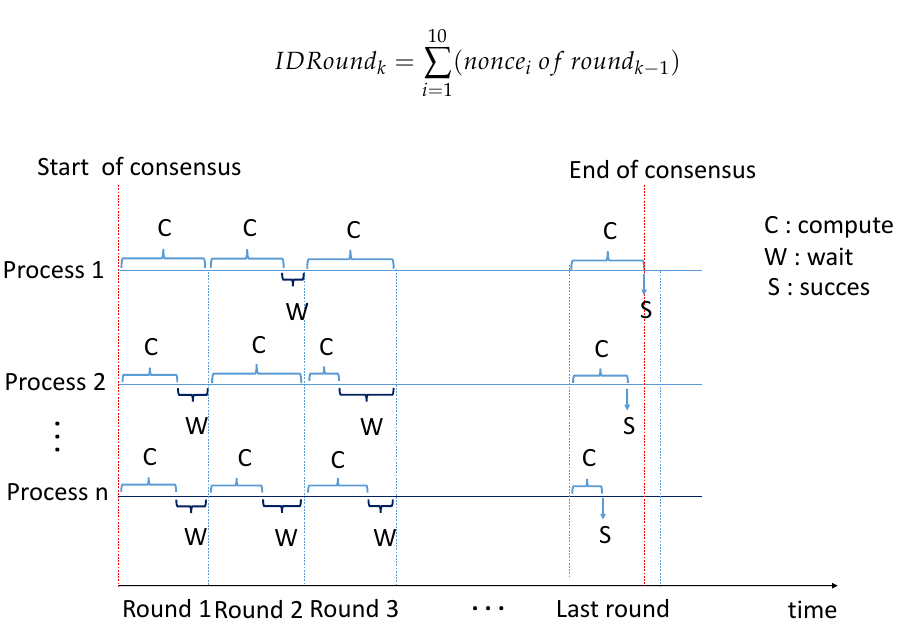
Figure 1. A Compute and Wait Consensus PoW